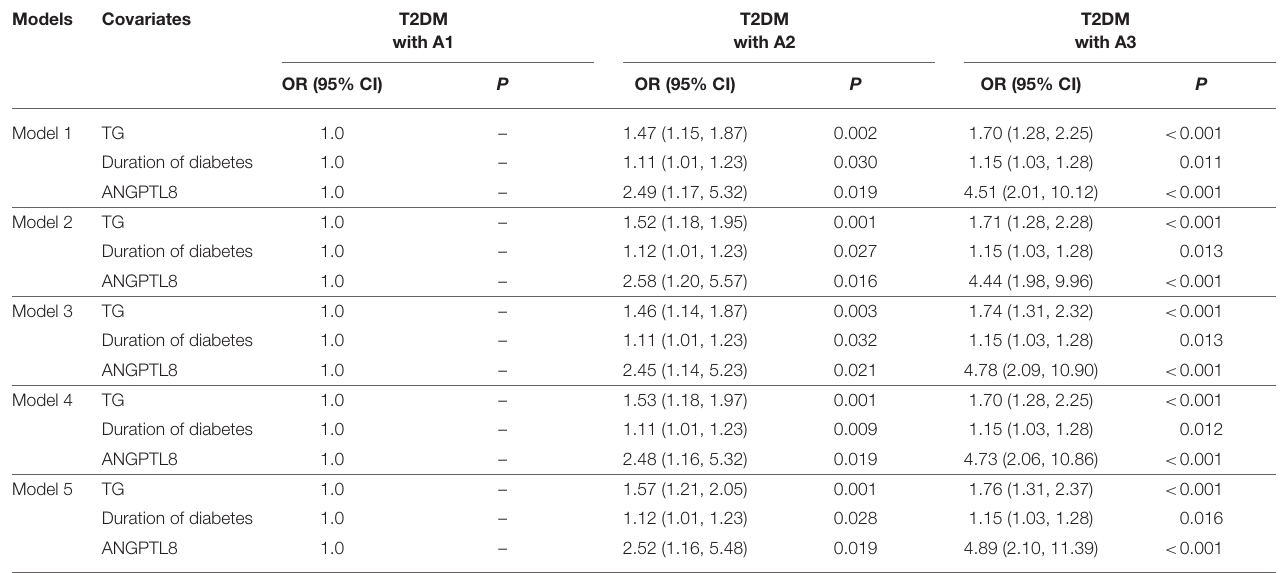
TABLE 4 | OR (95% CI) by binary logistic regression models for albuminuria.